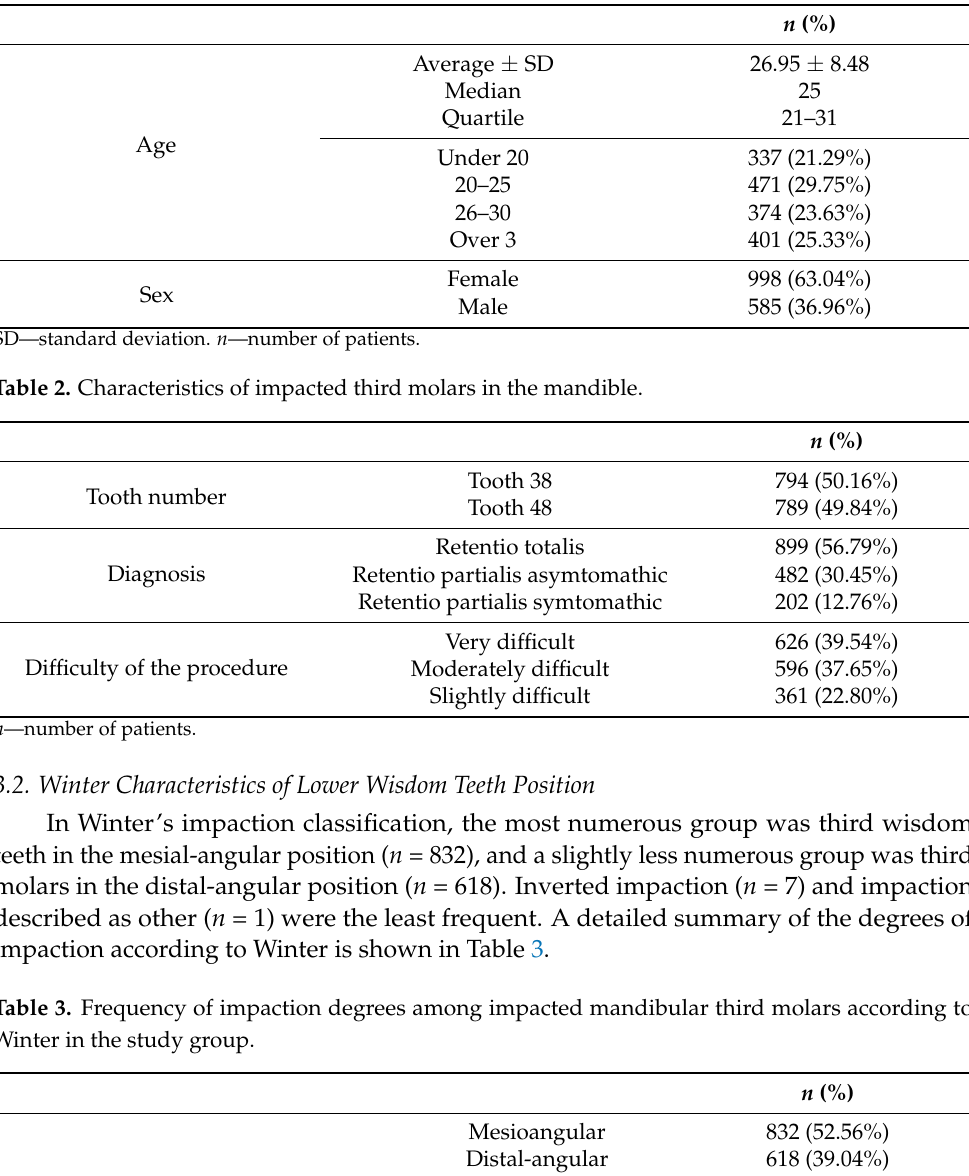
Table 1. Characteristics of the study group.